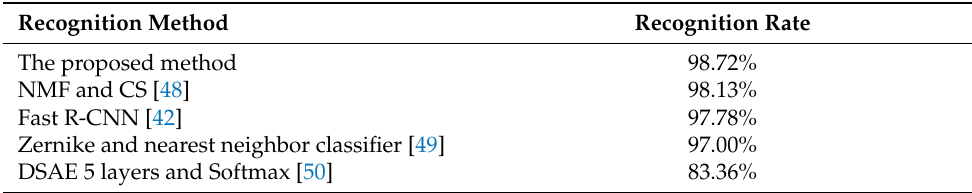
Table 6. Comparison results on the MU HandImages ASL